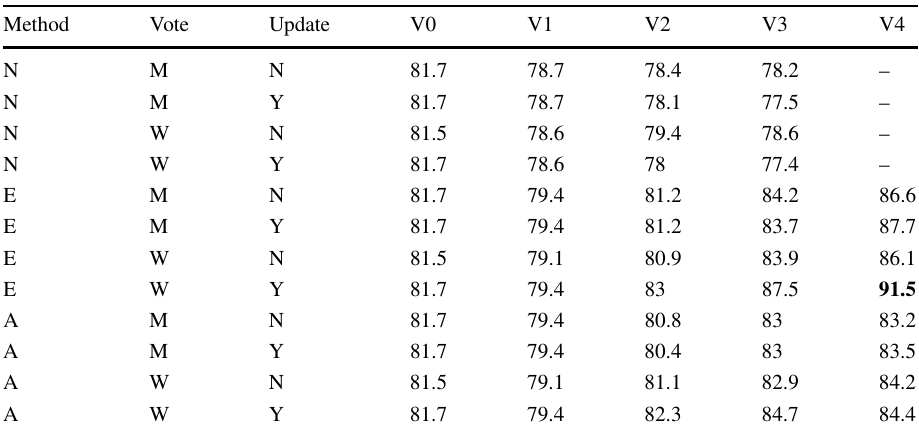
Table 4 Diabetic retinopathy specificity results